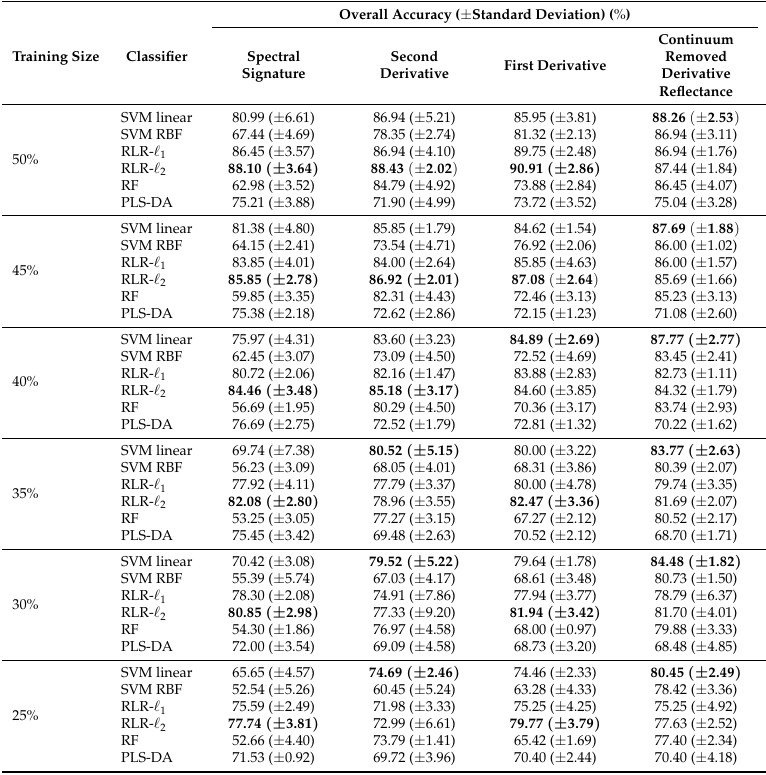
Table 17. Vegetation types identification accuracies (overall accuracy ( ± standard deviation) in %) on [350–750